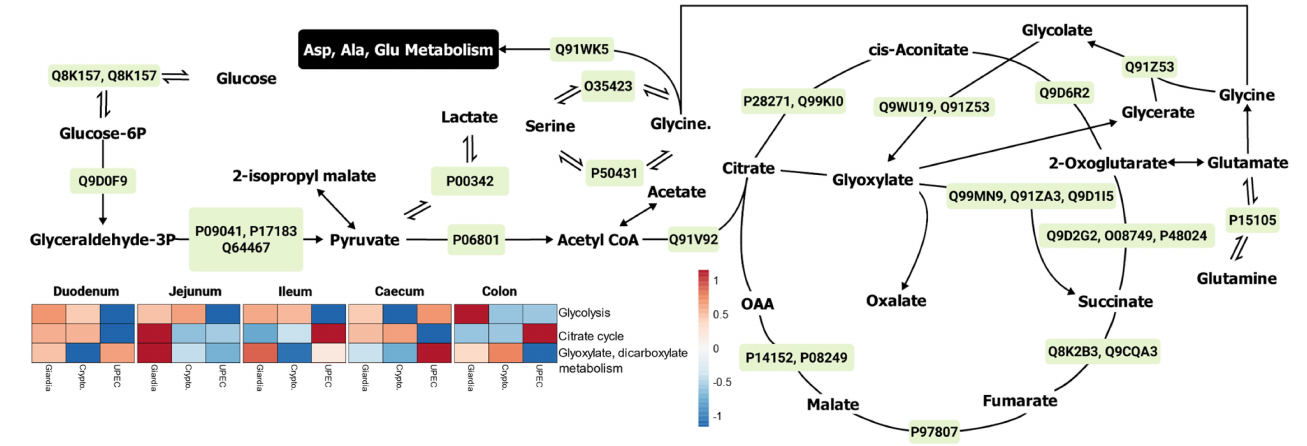
Figure 3. The major proteins (green boxes) and metabolites contributing to the energy metabolism in mouse gut during giardiasis. The heatmap represents Log 2 Fold change-based relative upregulation (red) and downregulation (blue) of individual pathways in the mice with infected gut with respect to the uninfected mice. Note: The protein identifiers (green boxes) refer to the Uniprot IDs. The heatmaps were designed using the Clustvis web tool [24]. Details for major proteins (Figure S4) and metabolites (Table S2) are provided in the Supplementary Materials.